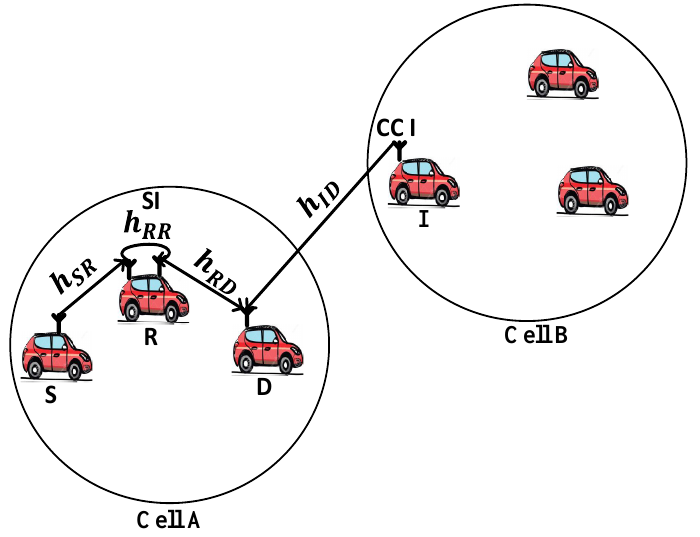
Figure 1. FDR with co-channel interference in vehicular cooperative wireless